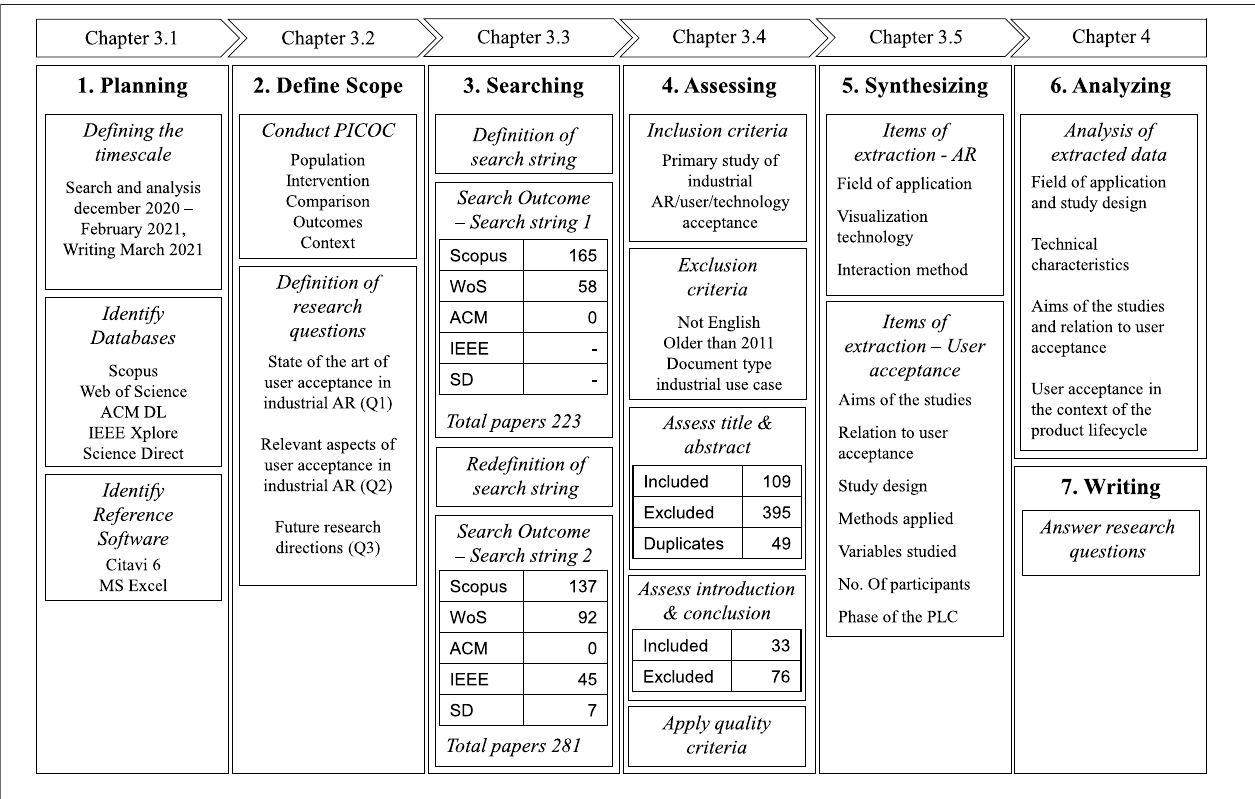
FIGURE 1 | Systematic literature review based on the methodology of Booth et al.